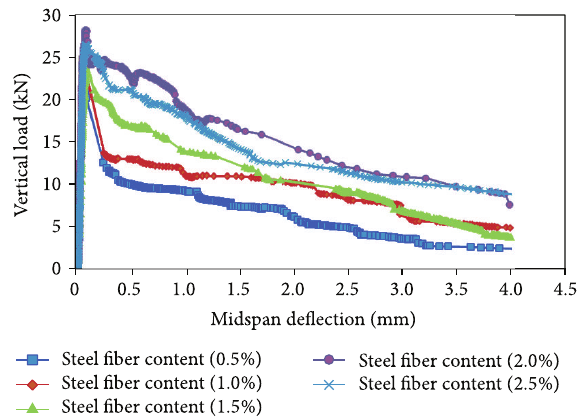
Figure 11: Contrast of “ 𝑃 𝑉 - 𝛿 ” curves of different steel fiber